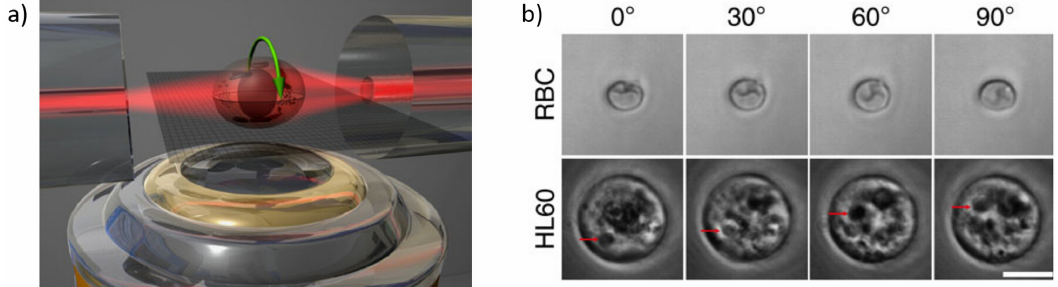
Figure 25. Optical cell rotator. ( a ) Illustration of the cell rotator realized in the two opposing laser radiation with an optical stretcher; ( b ) Microscope image sequences showing precise control of the cell orientation with red blood cell and HL60 cell. Figure reproduced from Reference [83] under CC-BY 4.0